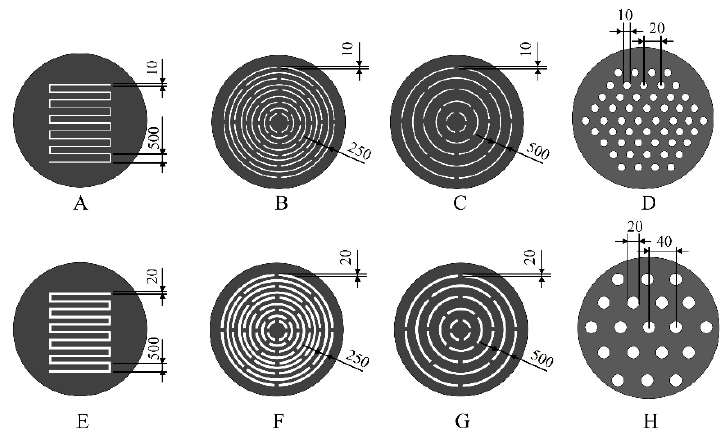
Figure 1. Overview of metal structure designs. The metal structures were designed with diameters of 15 mm and slit widths of 10 µm and 20 µm. Types A and E are comb-shaped, and Types B, C, F, and G are structures with multiple slits arranged in an arc shape. Types A–C and E–G have elastic structures and are designed to deform into three-dimensional shapes due to hydrodynamic force. The reason for utilizing different slit widths of 10 µm and 20 µm was to confirm that the thin film could be fabricated as the designed structure. The structures with fine pores on flat plates in Types D and H were fabricated to demonstrate the designs that needed to be devised.